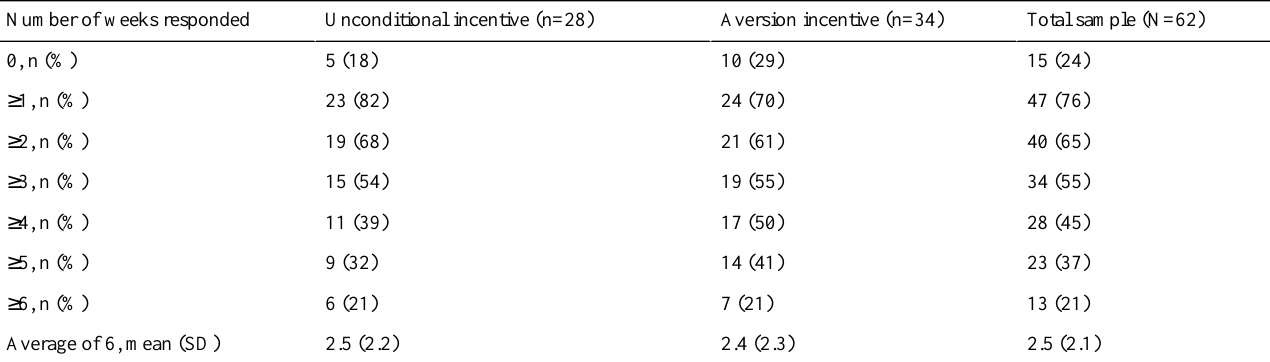
Table 4. Number of weeks the participants responded to the intervention activities by treatment group.